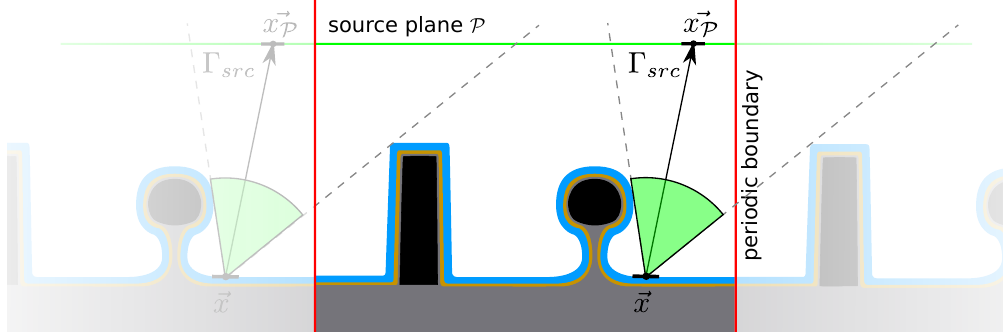
Figure 9. Schematic representation of the bottom-up flux calculation for modern gate structures, using periodic boundary conditions, meaning the entire simulation domain is repeated at the boundaries. The black arrow indicates the direction used to find the direct flux incident on (cid:126) x from a single particle source at (cid:126) x P with a source distribution of Γ src . The flux of all visible source plane elements, indicated by the green arc, is summed to give the total direct flux on (cid:126) x